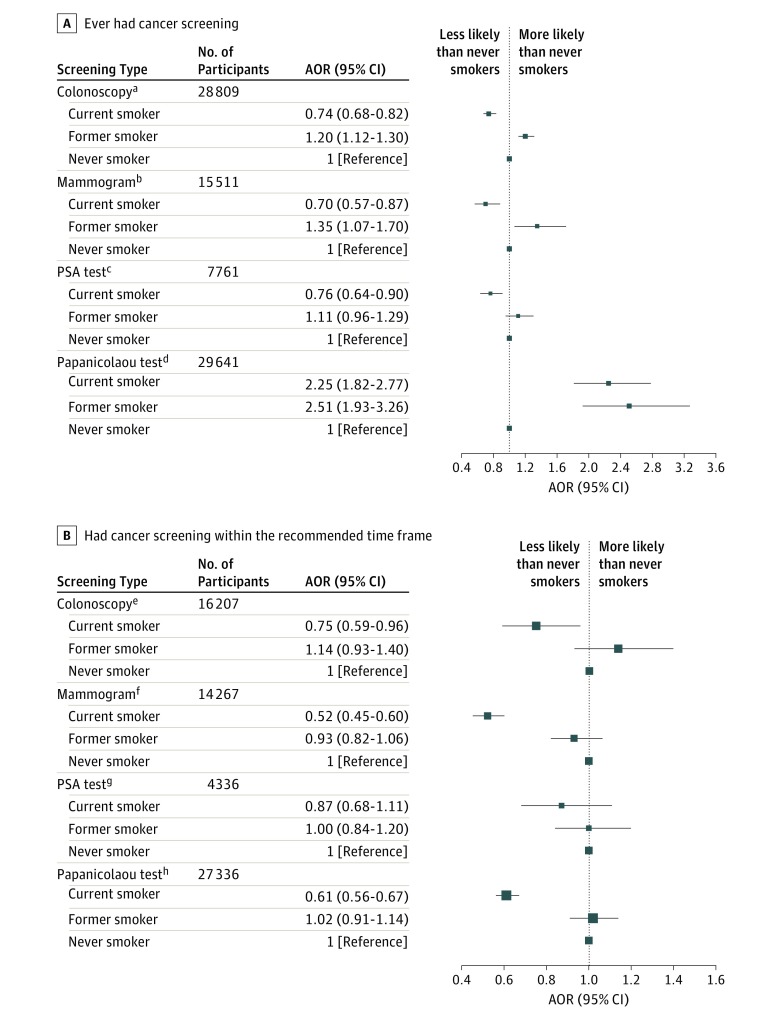
Forest Plot Depicting Adjusted Odds Ratios (AORs) of Cancer Screening for Former and Current SmokersNever smokers served as the reference group. PSA indicates prostate-specific antigen. The size of each data point is inversely related to the 95% CI size.aIncludes adults aged 50 to 75 years.bIncludes women aged 50 to 74 years.cIncludes men aged 55 to 69 years.dIncludes women aged 21 to 65 years without prior hysterectomy.eIndicates within 10 years.fIndicates within 2 years.gIndicates within 1 year.hIndicates within 3 years.